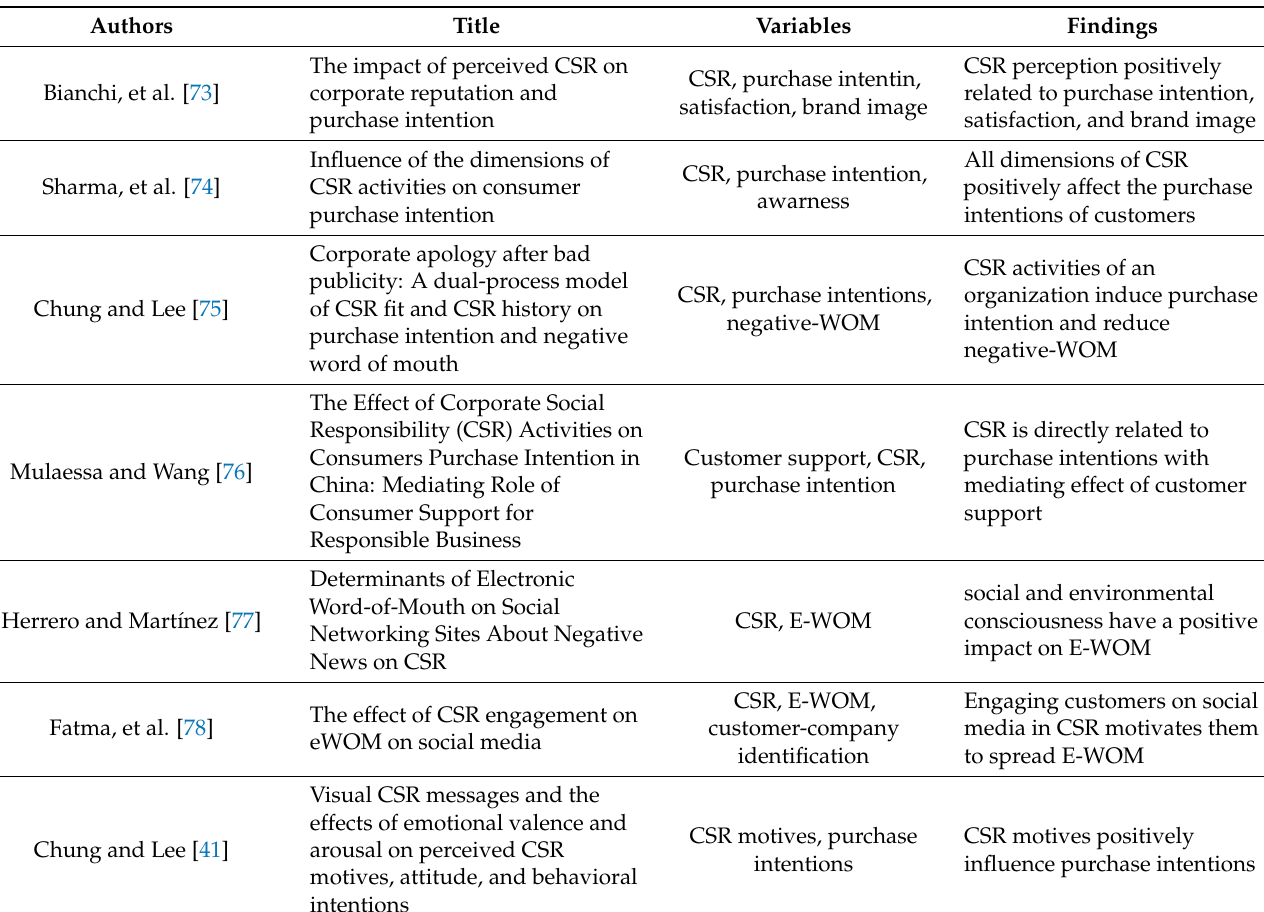
Table 1. Previous contributions and